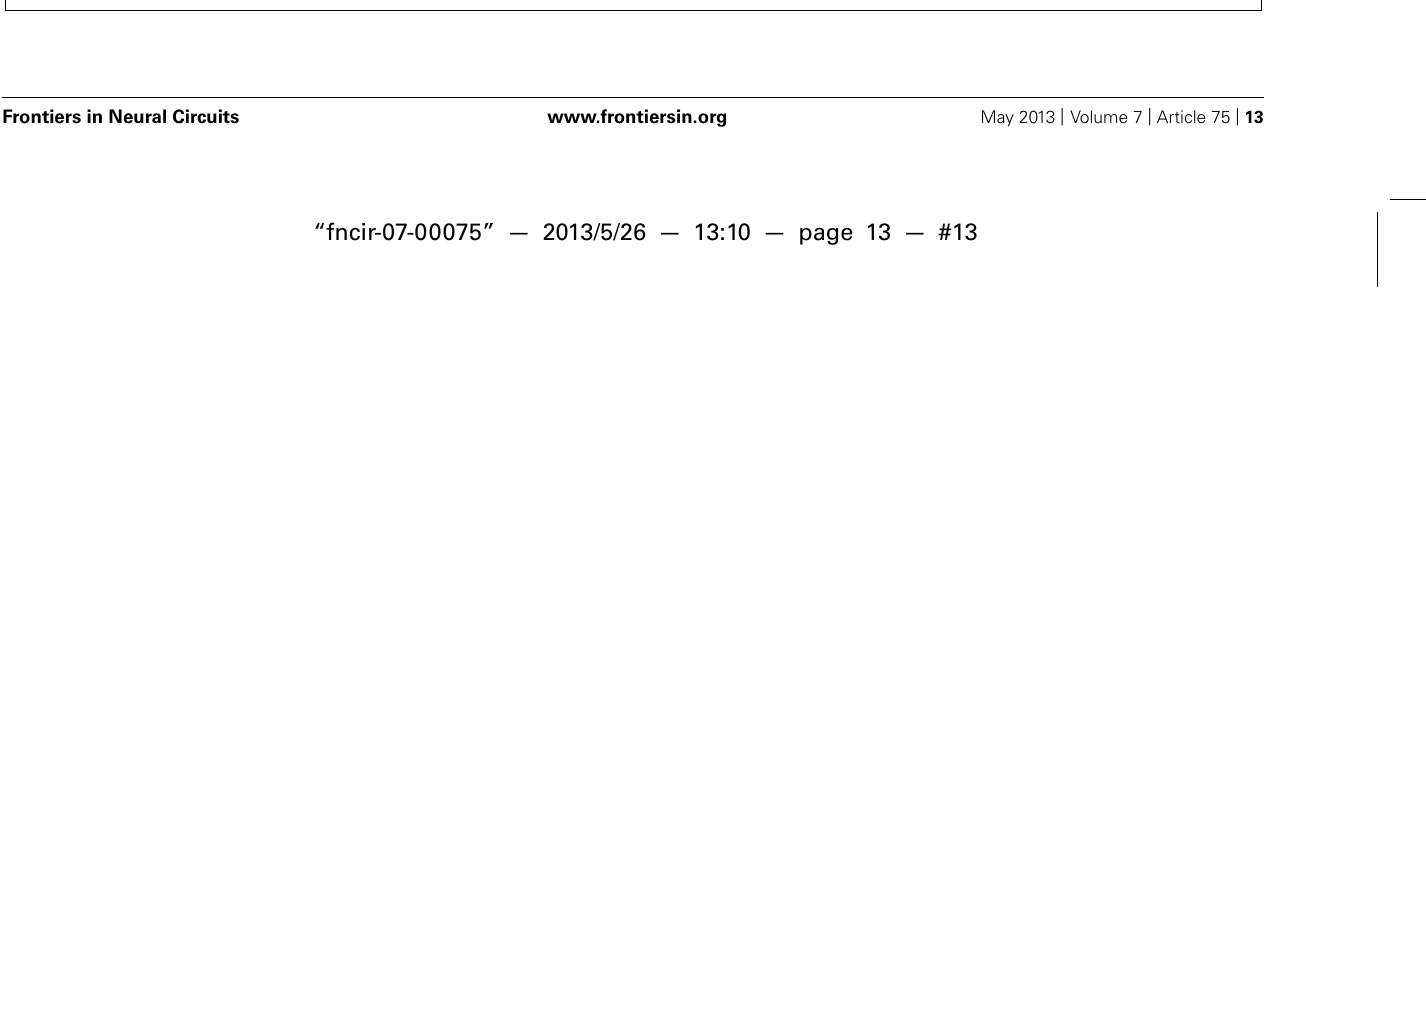
same amount of projections from each neuron located in all directions at the same distance from them ( C , bottom).Therefore, as shown in (D) , a section can be cut out to make a two-dimensional input map; in other words, one can obtain input intensity map i ( x , y ), which is the density of axon boutons derived from presynaptic neurons within a red cube located at horizontal distance x and normalized cortical depth y and closely apposed to the postsynaptic CTN dendrites within the green square prism. In this estimate, the number of neurons in the cube located at ( x , y ) is calculated from the density of presynapticVGluT1 mRNA-expressing neurons at depth y . (E) Input intensity map i ( x , y ). From the viewpoint of CTN dendrites in a unit prism, L4 spiny neurons are the most abundant source of local excitatory inputs.The regions encircled by black borders in (E) show significantly high i ( x , y ) ( > mean + 2SD). For more detail, see Tanaka etal. (2011b). Modified with permission from Figures 5–8 of Tanaka etal.